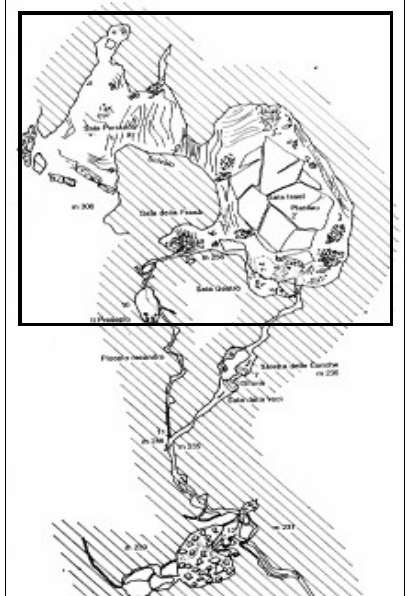
Figure 1. Planimetry of the cave. The surveyed part is